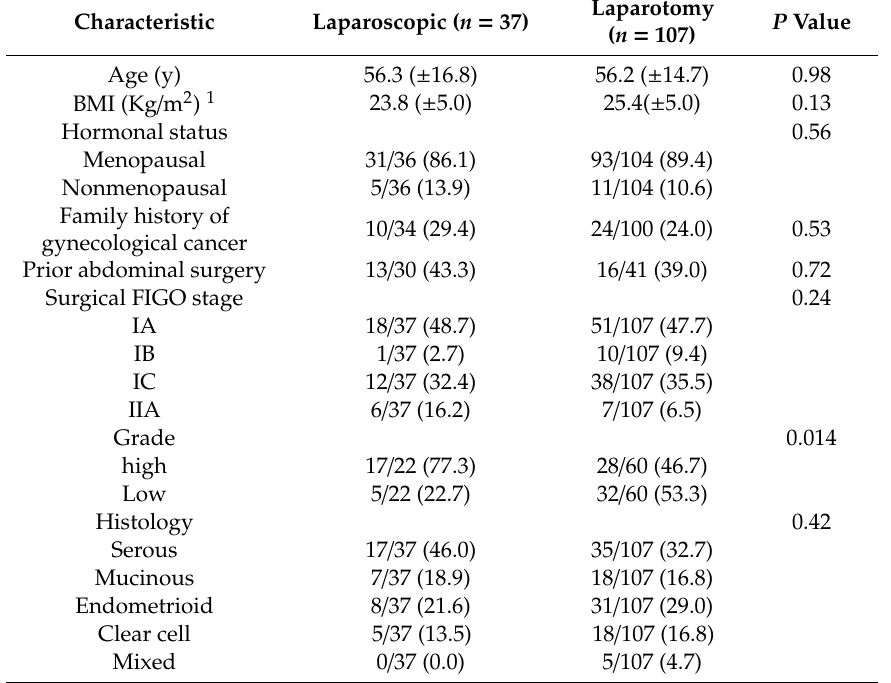
BMI = body mass index, FIGO = International Federation of Gynecology and Obstetrics. Values are expressed as mean ( ± standard deviation) or no. / total no. (percentage). 1 19 missing values (17 patients with